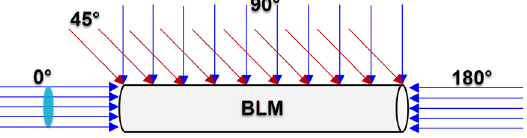
FIG. 9. The calculation model of response functions for particles traversing the BLM at four incident